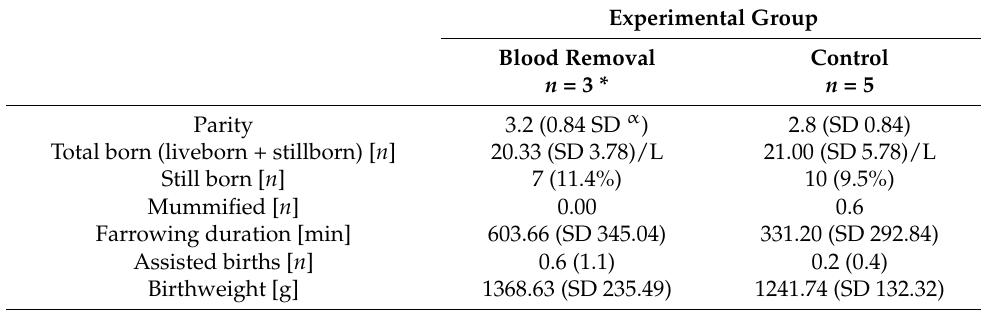
Table 8. Clinical outcomes at farrowing in Trial